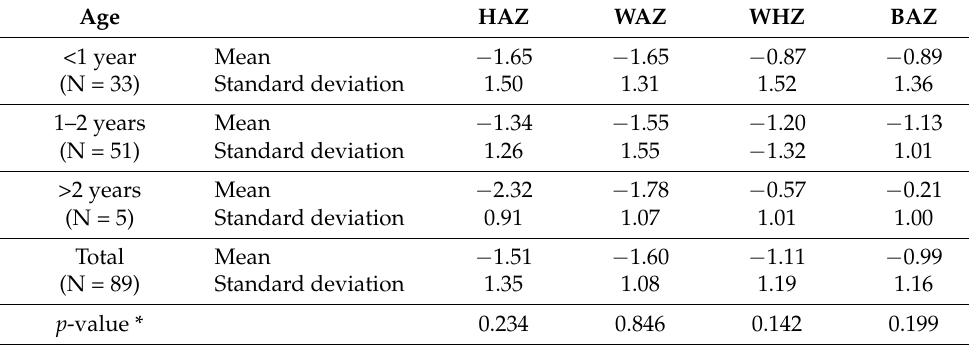
Table 3. Anthropometric values for the studied children from <1 to >2